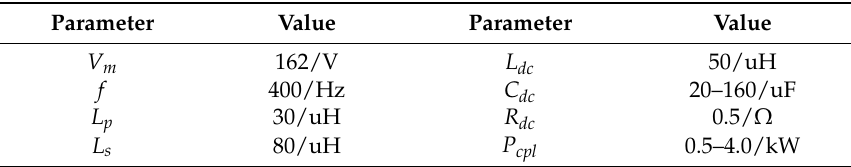
Table 1. Simulation parameters of aircraft power system.